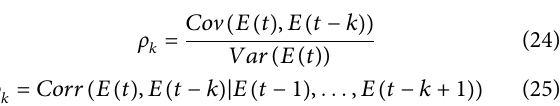
Frontiers in Energy Research |